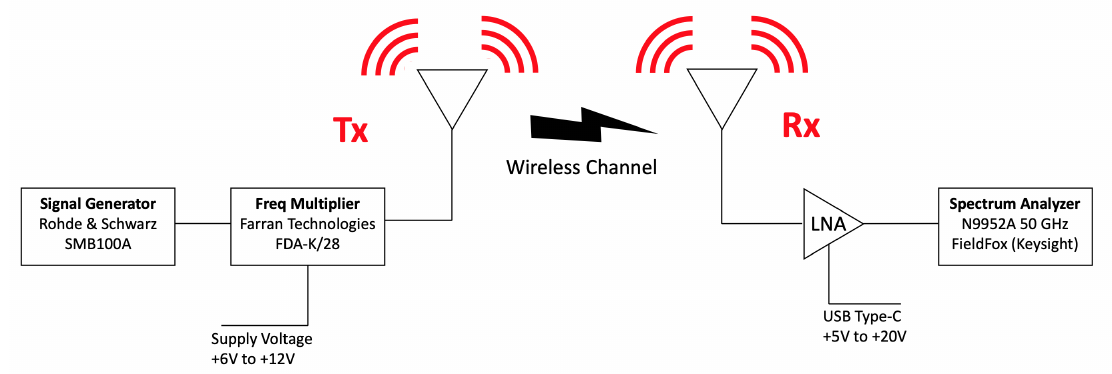
Figure 6. Schematic view of the deployed equipment during the campaign of measurements. Measurements were performed at 28 GHz frequency